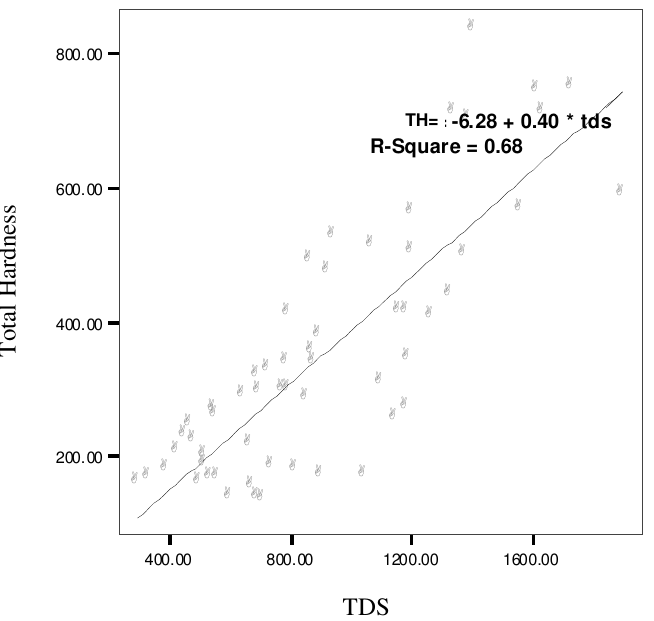
Figure 3. Correlation between total dissolved solids and total hardness